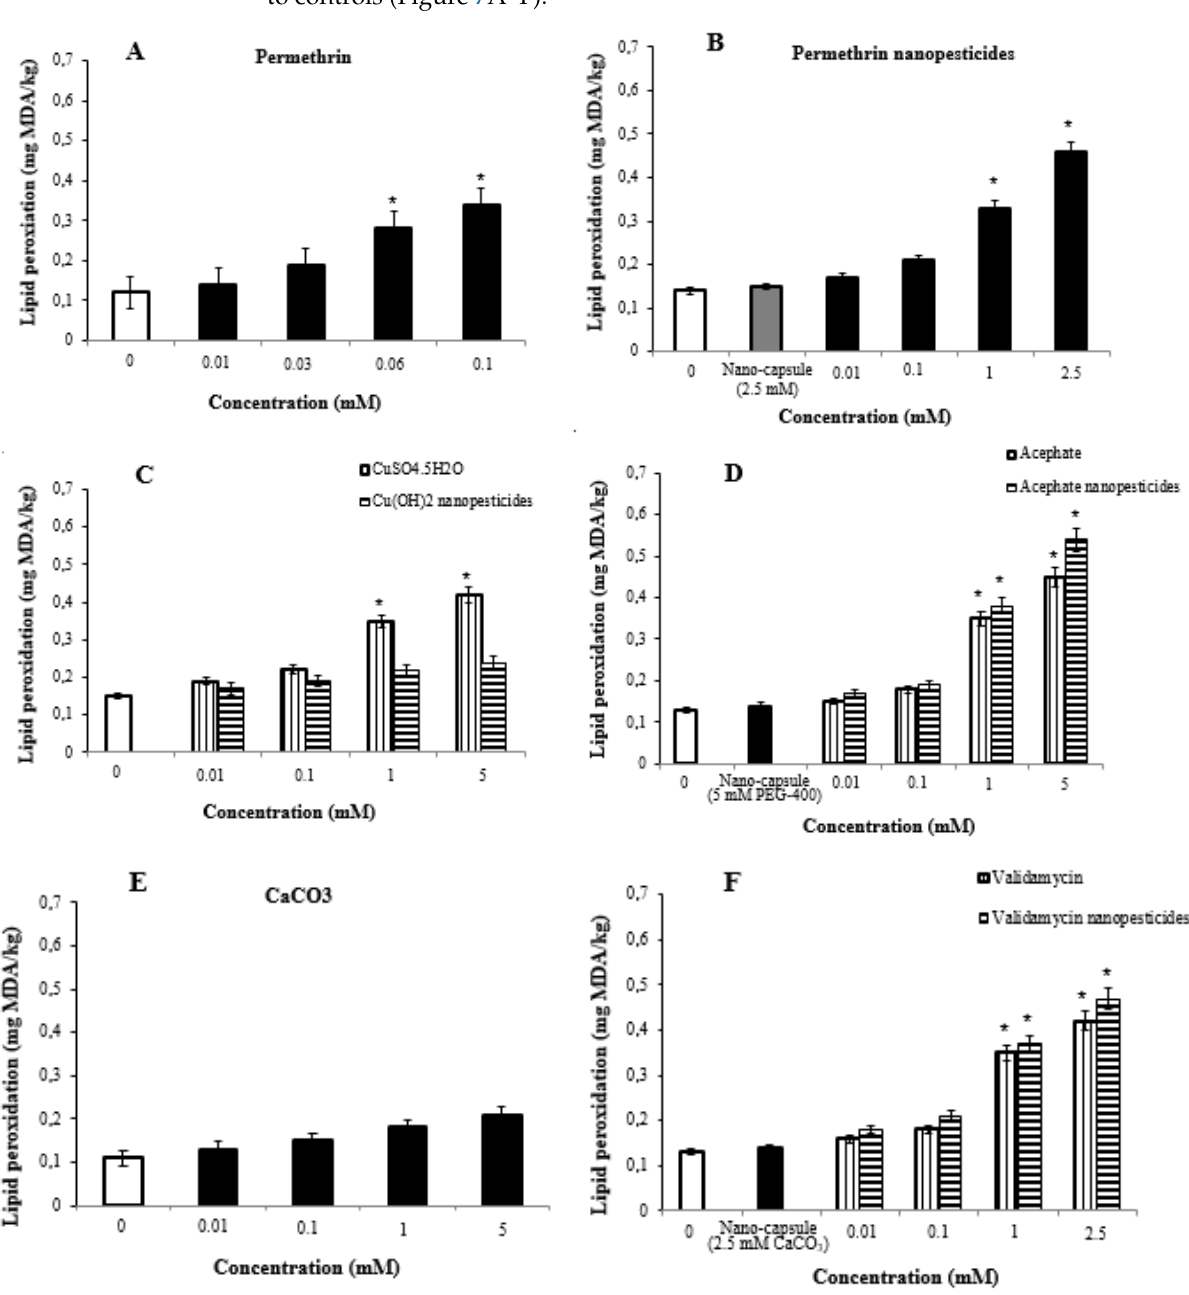
Figure 7. Lipid peroxidation, measured by TBARS (thiobarbituric-acid-reactive substances) accumulation in Drosophila treated with different concentrations of permethrin ( A ), permethrin nanopesticides ( B ), CuSO 4 · 5H 2 O and Cu(OH) 2 nanopesticides ( C ), acephate and acephate nanopesticides ( D ), CaCO 3 ( E ), and validamycin and validamycin nanopesticides ( F ). Each point represents a mean of 3 replicates ± SE; * p ≤ 0.05 when compared to the negative control using one -way ANOVA.